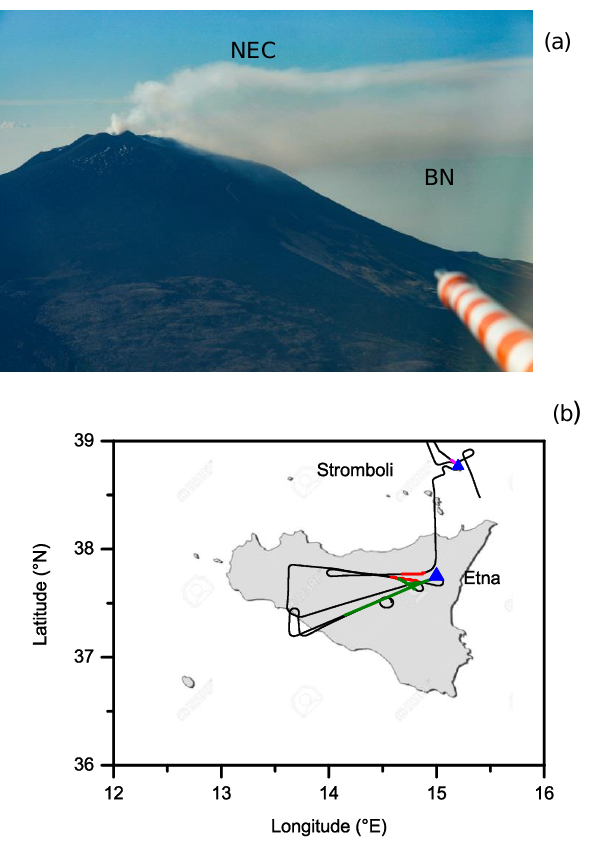
Figure 1. (a) Degassing Etna plumes from Northeast (NEC) and Bocca Nuova (BN) craters as seen from the DLR Falcon Research aircraft (Photo: Bernadett Weinzierl); (b) Falcon flight track over Sicily on 30 September